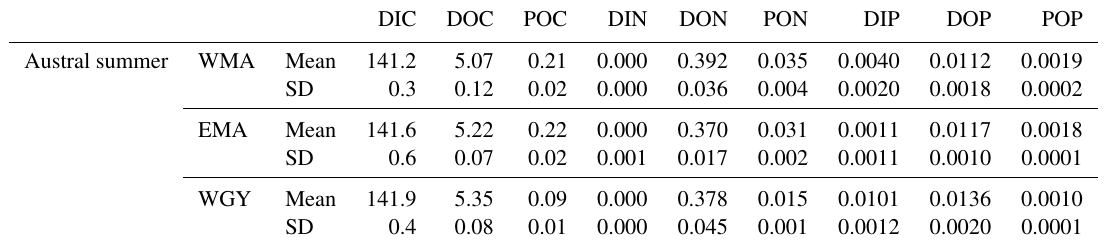
at Tutuila with an annual mean of 397.3 ppm. The X CO data 2 were converted to p atm considering 100 % humidity and a CO 2 total pressure of 1 atm (101 325 Pa), following Weiss and Price (1980), with surface seawater temperature and salinity of each area (Table 5). A total pressure of 101 260 ± 180